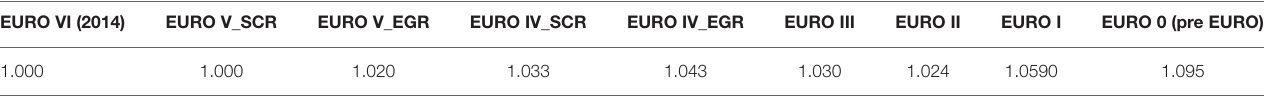
TABLE 8 | Fuel consumption ratios of engine generations (Matzer et al.,